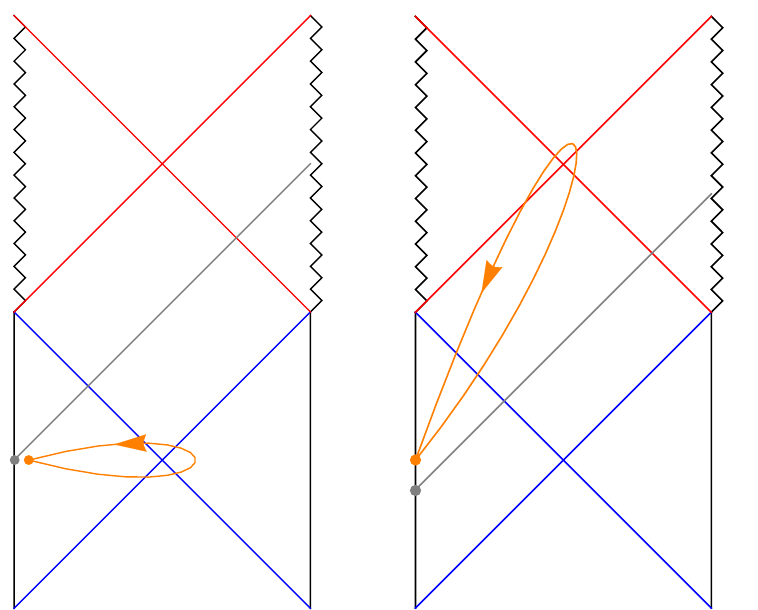
Figure 3 . Left: carrying an operator around the outer bifurcate horizon gives rise to the KMS condition. Right: carrying an operator around the inner horizon gives rise to a new periodicity